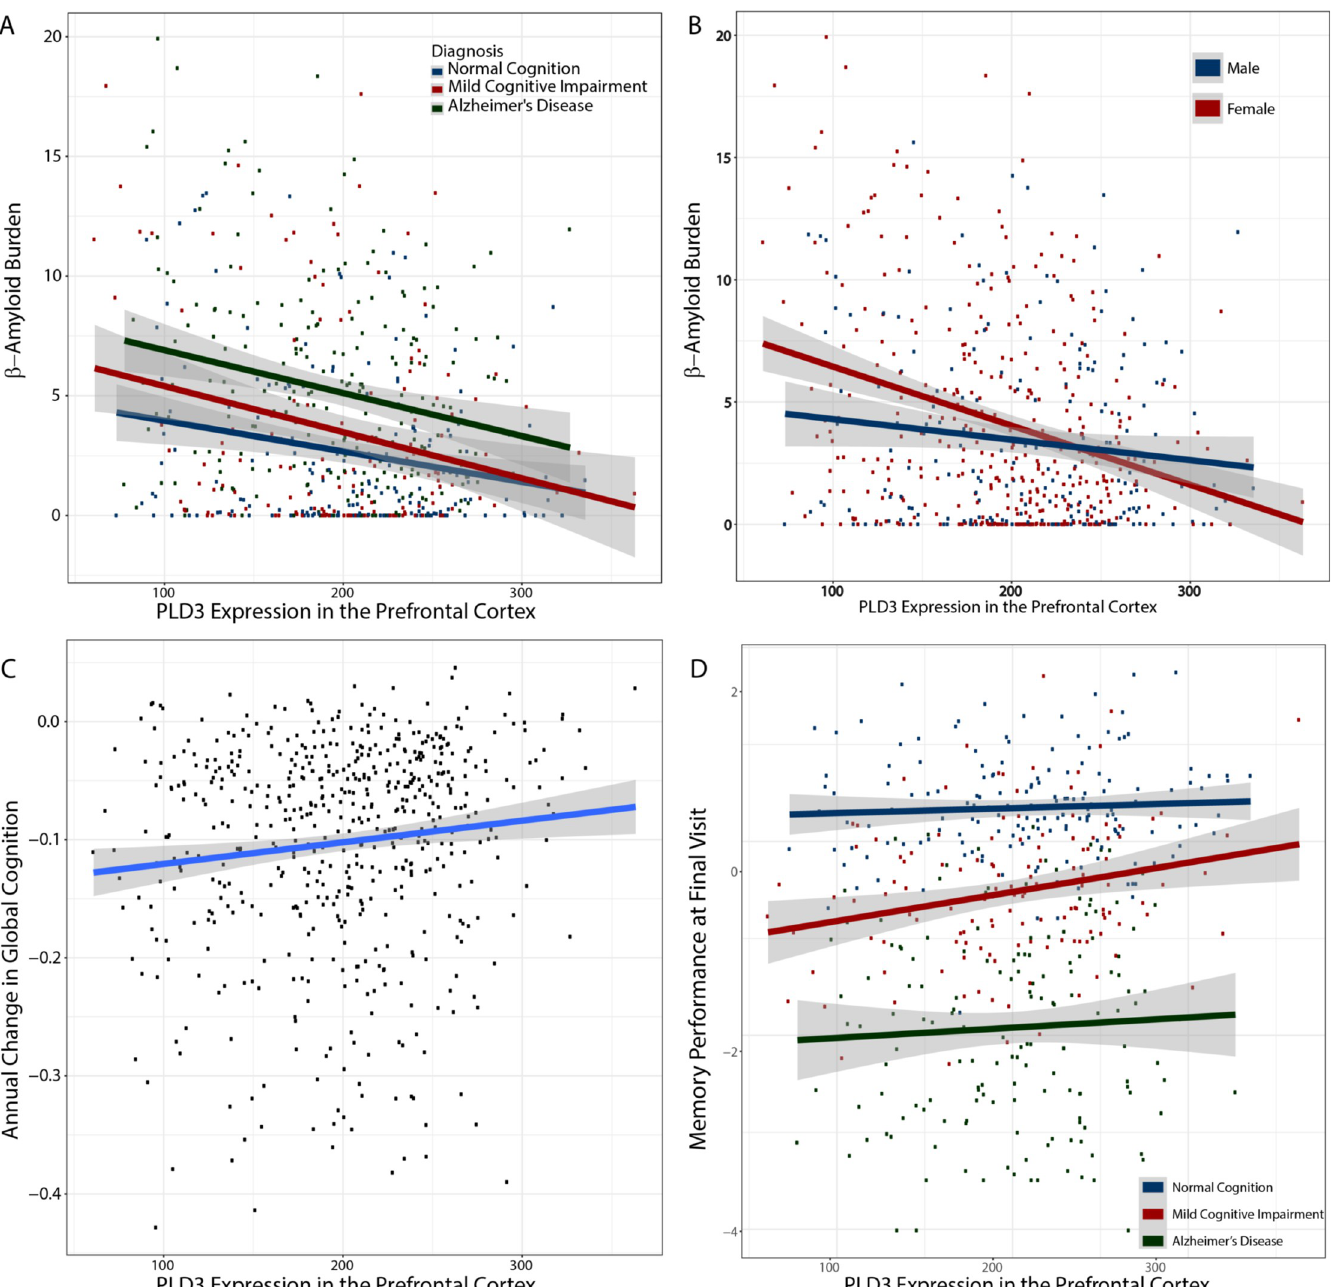
Fig 3. PLD3 expression correlates with neuropathology and cognitive trajectory. Human hippocampal PLD3 mRNA counts (in transcripts per million, TPM) were obtained from the ROS/MAP cohort A. Regression analysis reveals across all clinical diagnoses, higher levels of PLD3 appear protective with respect to lower β -amyloid plaque counts in prefrontal cortex. B. Protective effect of PLD3 expression on β -amyloid burden is stronger in women. C. Across all clinical diagnoses, higher levels of PLD3 correlate with slower rates of cognitive decline. D. PLD3 expression correlates with memory